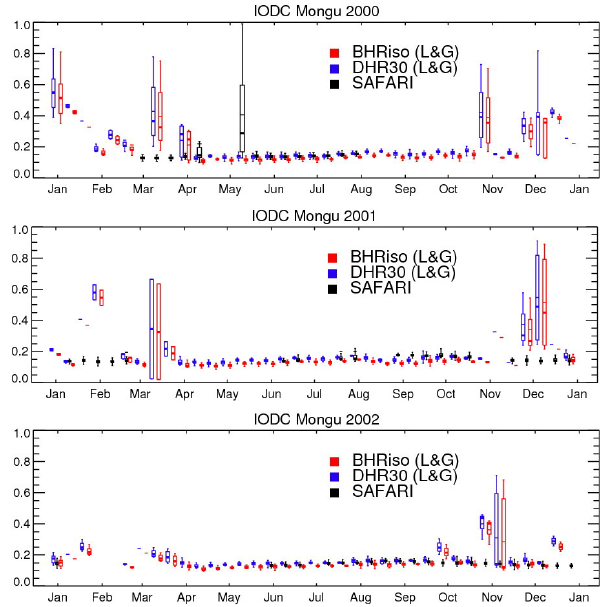
Figure 9. Same as Fig. 8 but for the IODC